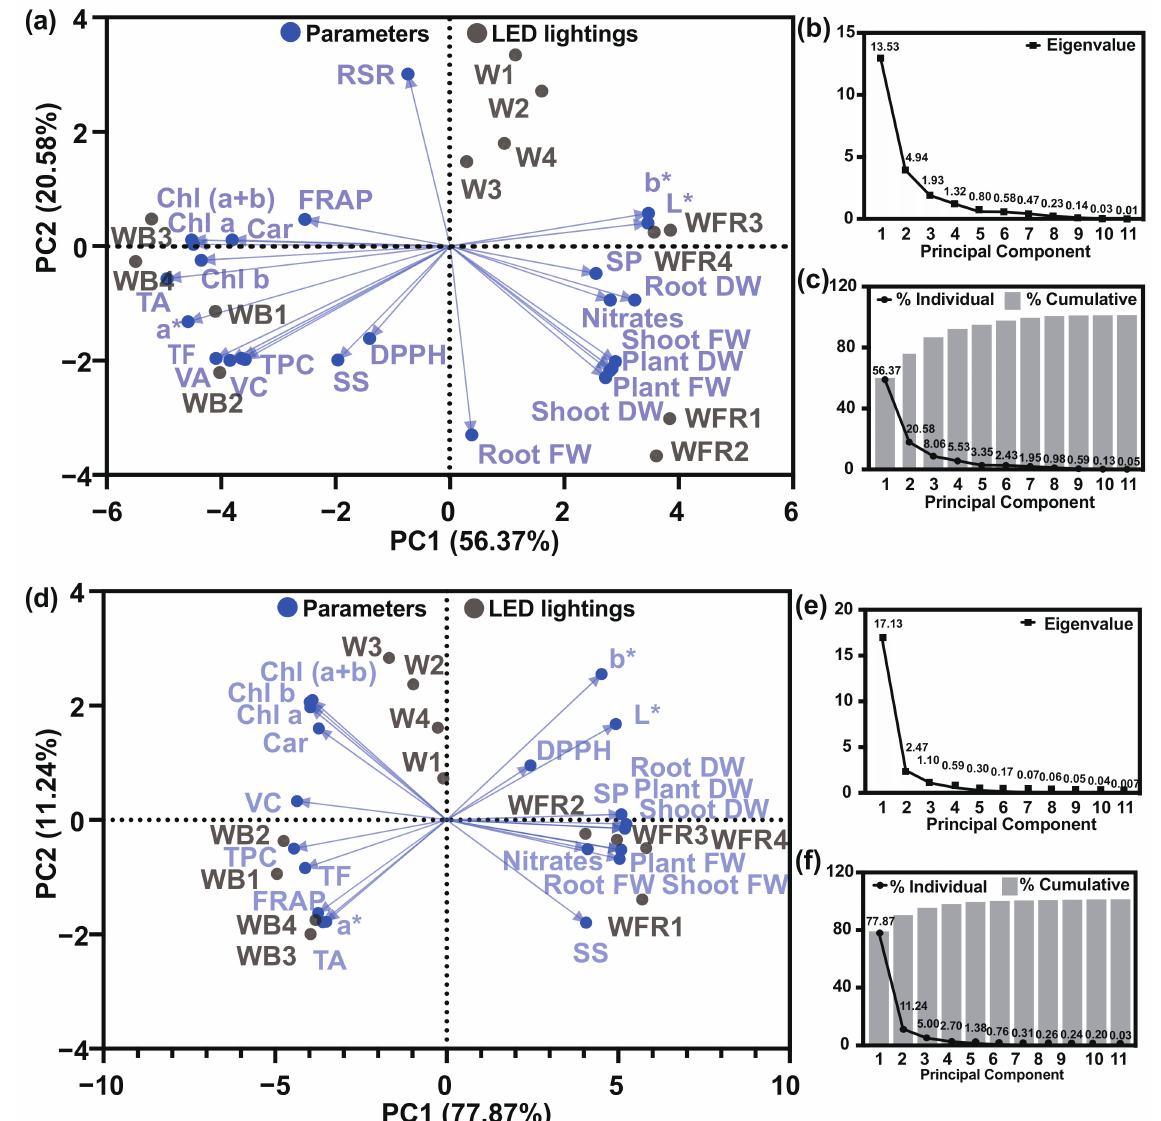
Figure 2. The principal compound analysis of overall quality of two lettuce cultivars. The biplot ( a ), eigenvalue ( b ) and variance proportion ( c ) of “Yanzhi”. The biplot ( d ), eigenvalue ( e ) and variance proportion ( f ) of “Red Butter”. FW = fresh weight, DW = dry weight, L* = lightness, a* = redness, b* = yellowness, Chl = chlorophyll, Car = carotenoids, TA = total antho- cyanins, DPPH = DPPH radical inhibition percentage, FRAP = ferric ion reducing antioxidant power, TF = total flavonoids, TPC = total phenolic compounds, SP = soluble proteins, SS = soluble sugars, RSR = root to shoot ratio, W = equalized- white light; WFR = W plus far-red light; WB = W plus blue